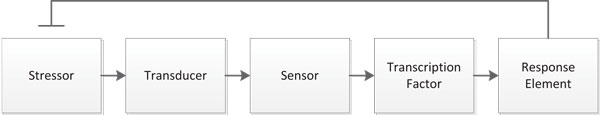
General scheme of stress response pathways. This figure explains the general flow of information in stress response pathways.